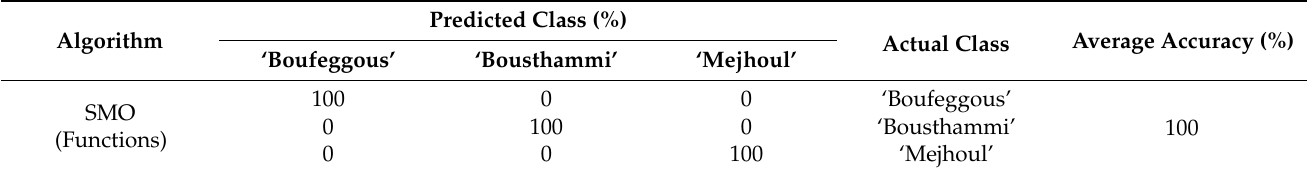
Table 3. Confusion matrices and average accuracies of discrimination of ‘Boufeggous’, ‘Bousthammi’, and ‘Mejhoul’ date palm fruits for the models built based on a set of image textures selected